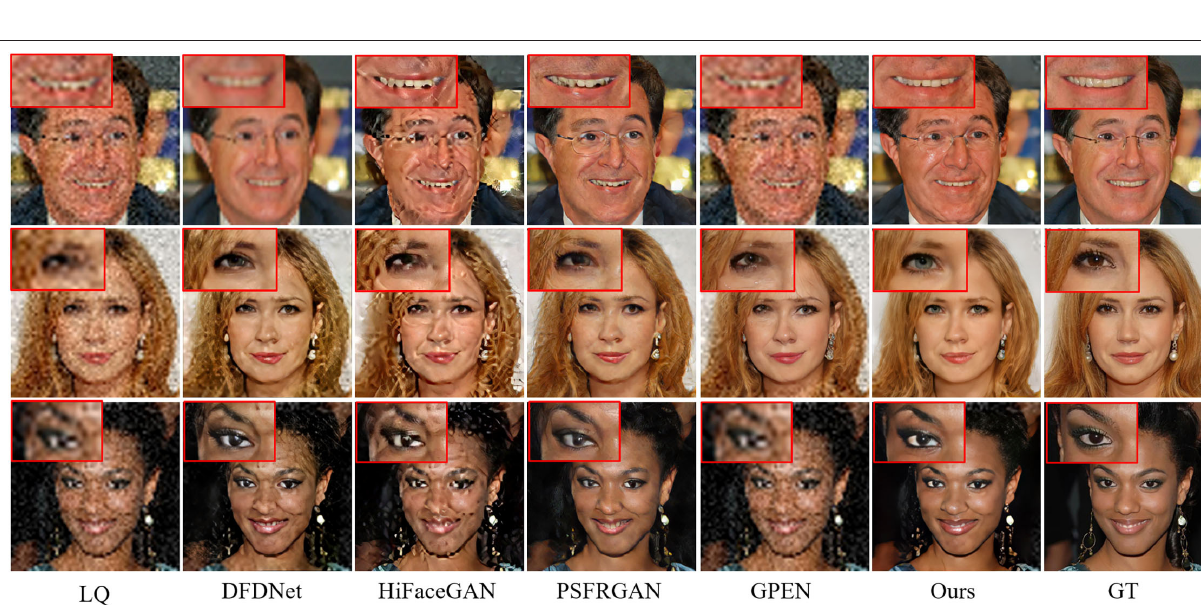
ground-truth with fewer artifacts and more details for all noise